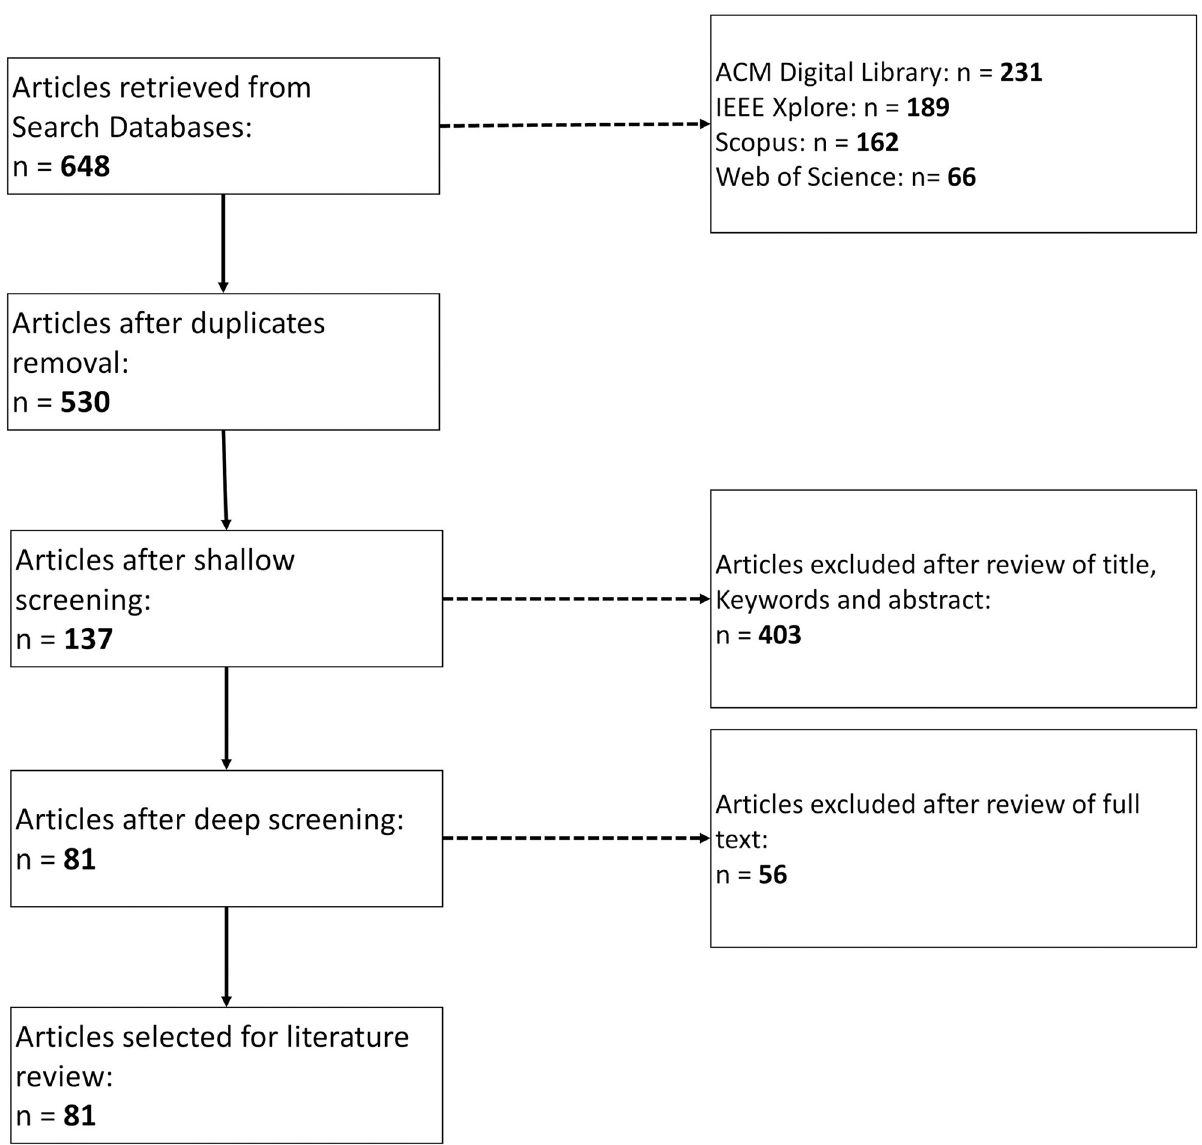
Fig 1. PRISMA flowchart. This PRISMA flowchart presents the main steps of literature selection, deduplication, shallow and deep screening, until the final collection is reached. Each step displays the amount of documents selected so far. Source: The authors (2022).